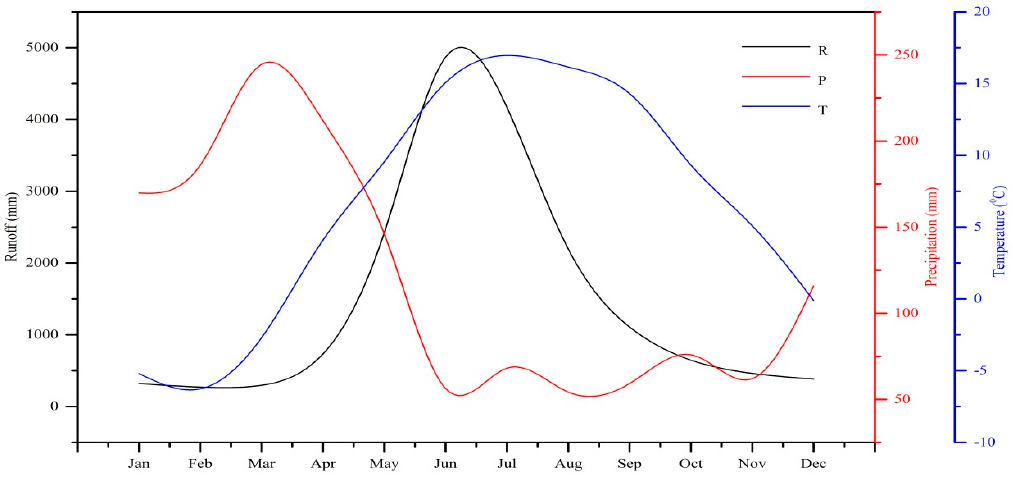
Figure 11. Inter-annual variability of temperature, precipitation and runoff for Zone I.